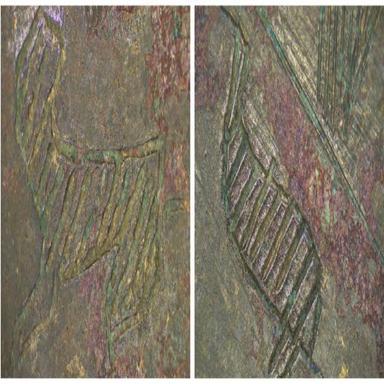
Digital microscopic image of the surface of sample QJZ 30, showing exquisite carved patterns. Image width: 8 mm.